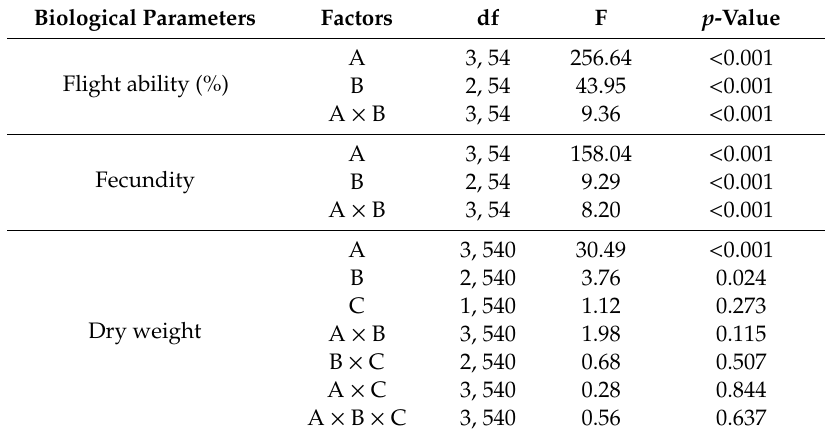
Table 3. Univariate analysis of e ff ects of factors on fitness traits (flight ability, fecundity, dry weight) of B. dorsalis